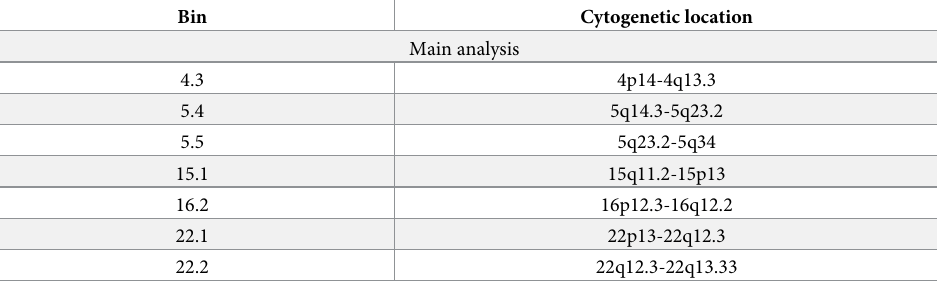
Table 1. Diabetic nephropathy genome scan meta-analysis results.